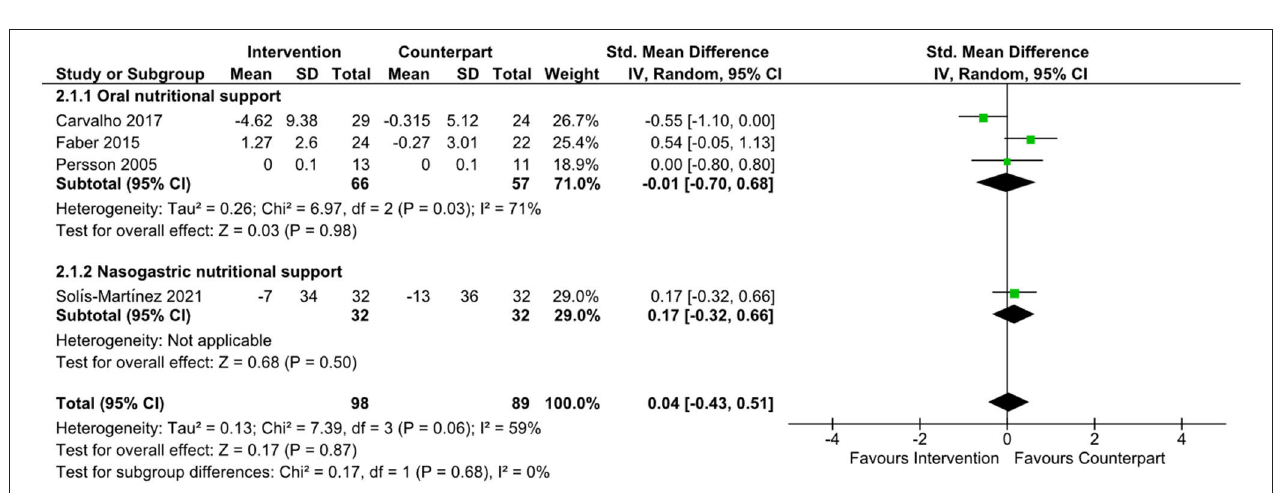
FIGURE 4 | Forest plot of standard mean difference in C-reactive protein